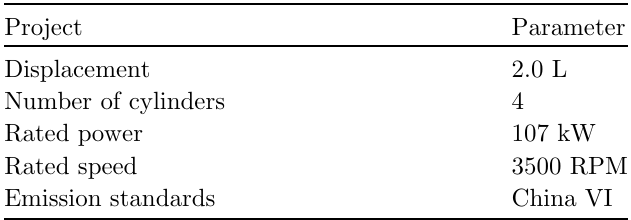
Table 3. Engine parameters.